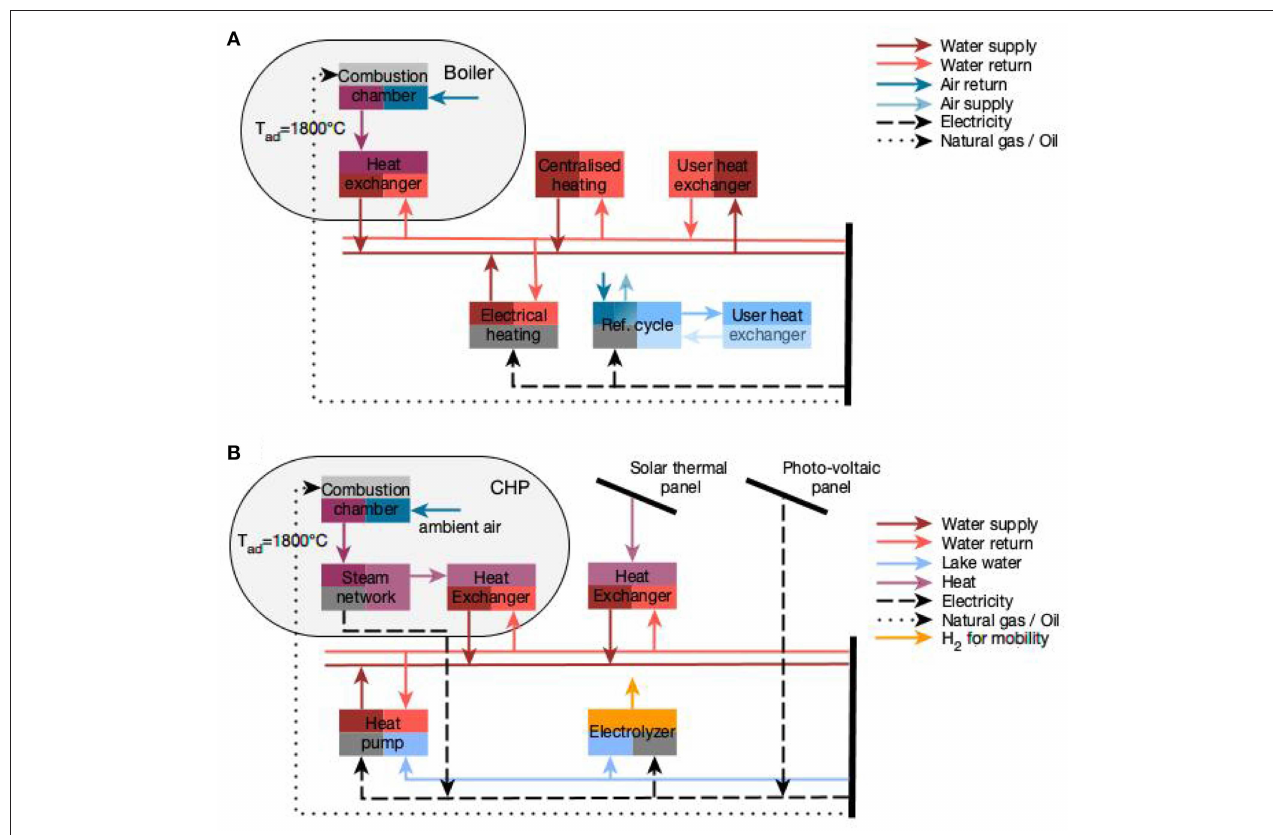
FIGURE 6 | Schematic description scenario 1 (A) and scenario 2 (B) .